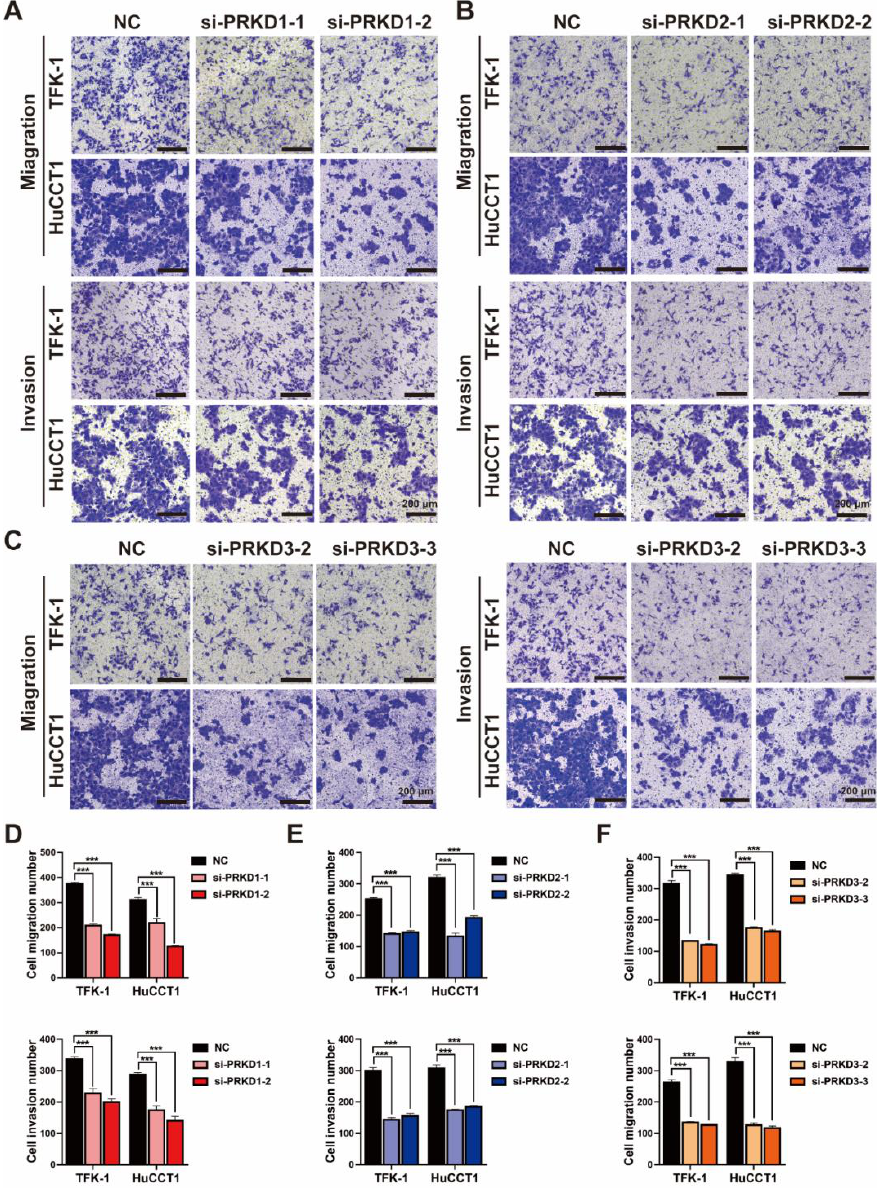
Figure 7. Experimental analysis of functional roles for PKD family in CCA cells: Transwell assay of TFK-1 and HuCCT1 treated with each specific siRNA for ( A ) PRKD1, ( B ) PRKD2, and ( C ) PRKD3, respectively (scale bars = 200 μm); the number of migrated and invaded cells for ( D ) PRKD1, ( E ) PRKD2, and ( F ) PRKD3, respectively. *** p < 0.001 determined by two-way ANOVA. Data are presented with means ± SDs and from three independent experiments.